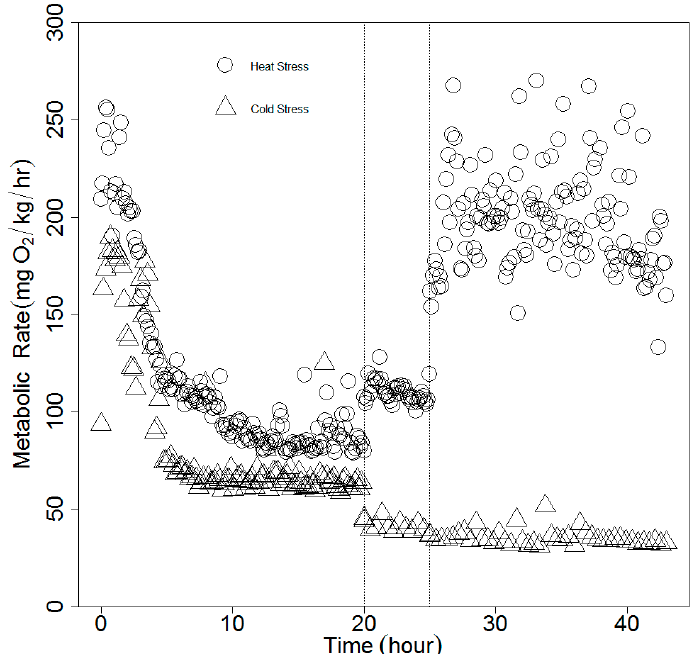
Figure 2. Time course of metabolic rate change in spotted seatrout under two sets of experimental conditions. Empty circles: heat stress; empty triangles: cold stress. Each dot represents the oxygen consumption rate from one respirometry cycle. Vertical dotted lines separate different temperatures. Within each treatment, from left to right: 20 °C, 25 °C, 30 °C (heat stress); 15 °C, 10 °C, 5 °C (cold stress). MMR was defined as the single highest MO 2 value at 15